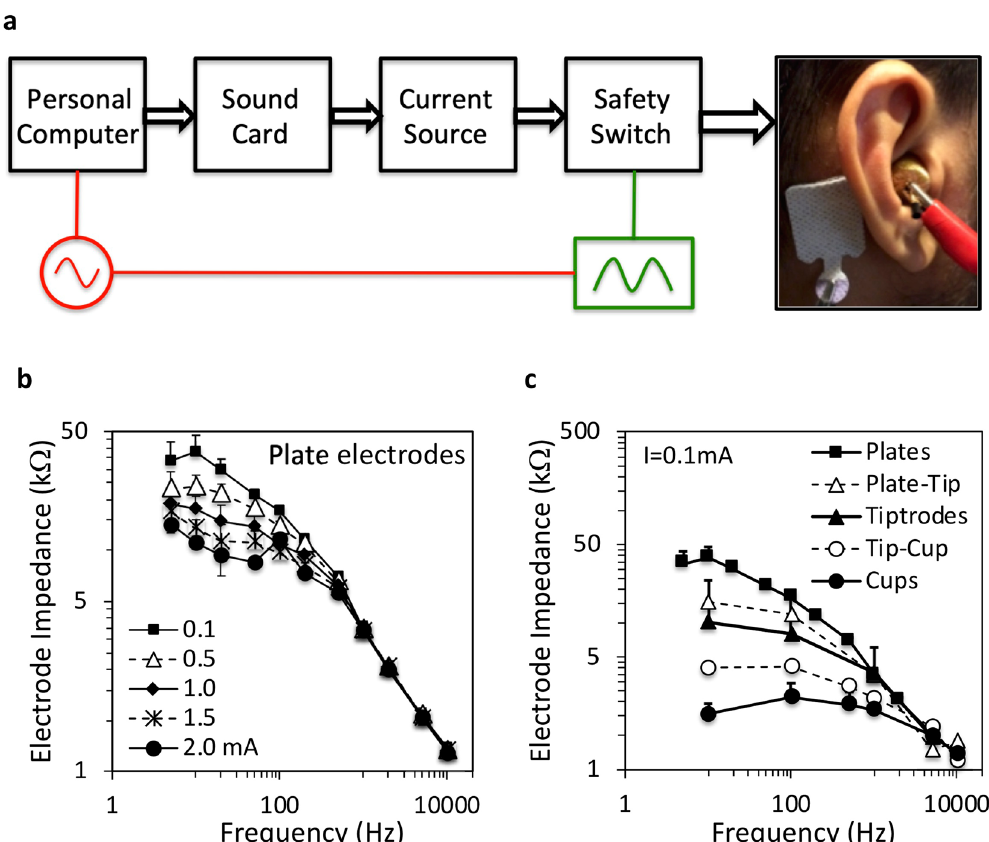
Figure 6. Transcranial electric stimulation setup and electrode impedance. ( a ) Block diagram of the step from personal computer to electrodes, showing a plate electrode on mastoid and a gold-plated tiptrode in the ear canal. The red circle represents a transformer power supply to isolate the power line from the subject and the green rectangle represents a monitoring oscilloscope. (b) Impedance for plate-to-plate electrodes as a function of stimulus frequency (x-axis) and stimulus level (symbols). (c) Impedance for different electrodes (symbols) as a function of stimulus frequency (x-axis) at a fixed 0.1-mA stimulus